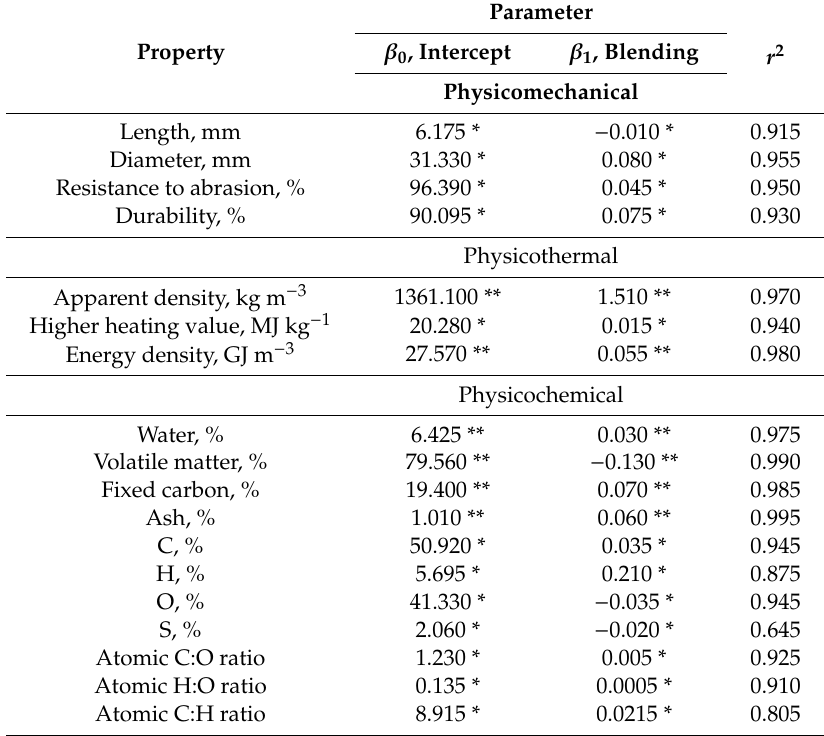
Table 3. Parameters and goodness-of-fit for the first-power models for the e ff ect of blending of residual biomass on the quality of hybrid non-wood